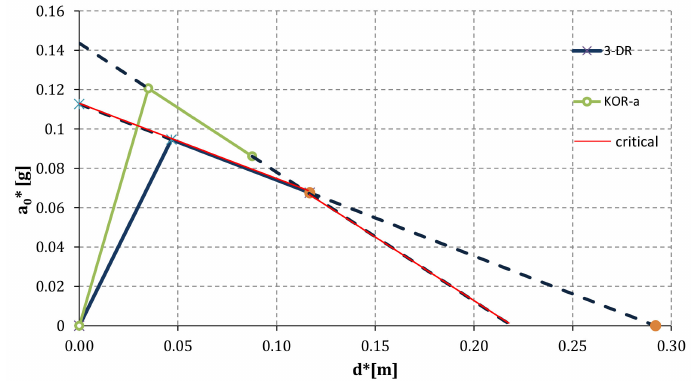
Figure 10. Capacity curve for Philotheou